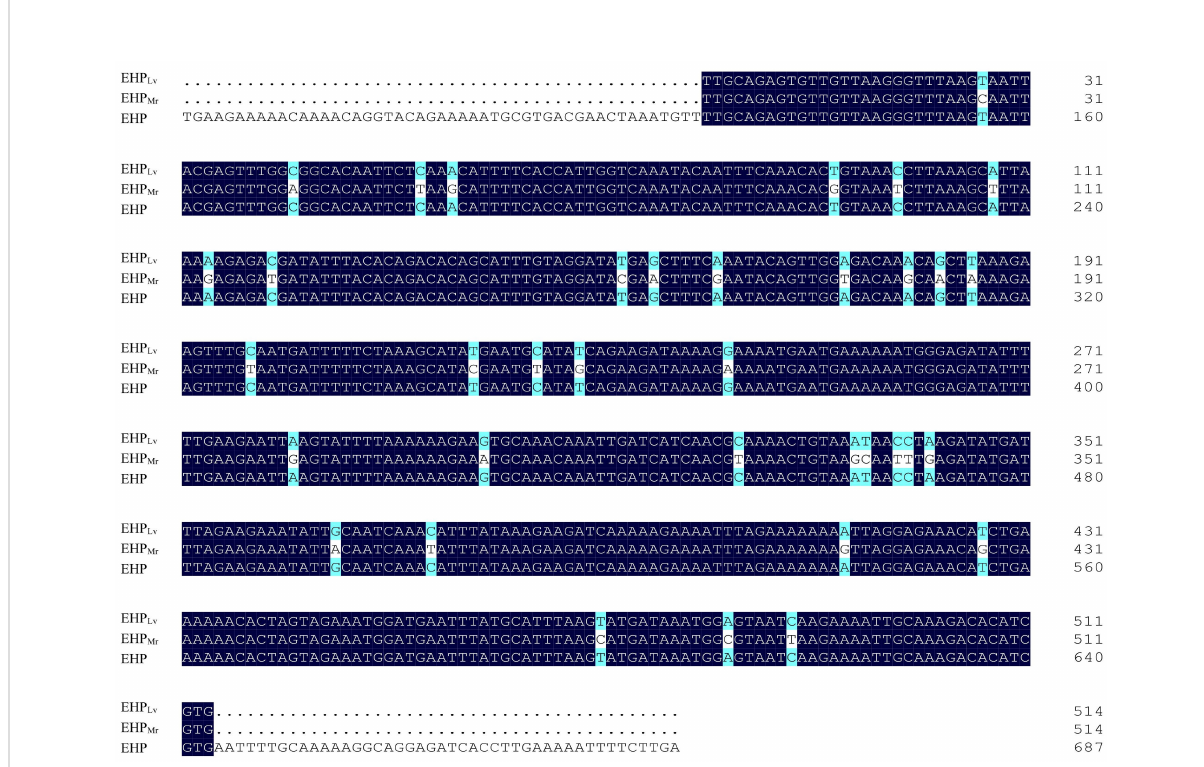
FIGURE 1 Alignment of partial nucleotide sequences of the SWP1 gene of EHP Lv , EHP Mr , and reference EHP (MG015710). The nucleobases with white differ from the consensus. The numbers on the right indicate the nucleotide